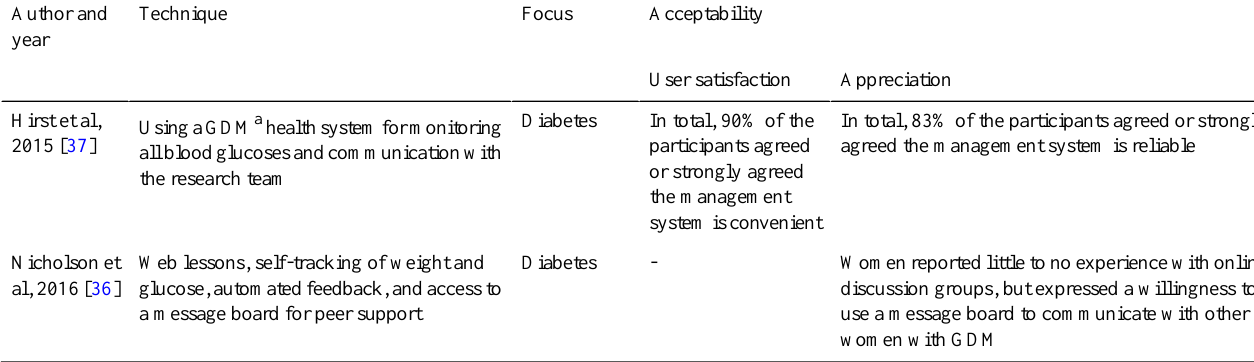
Table 2. Overview of studies reporting on medical (interventions) apps related to pregnancy: acceptability. AcceptabilityFocusTechniqueAuthor and